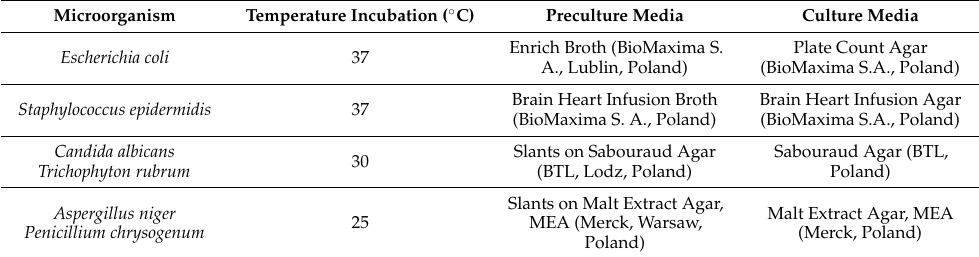
Table 1. Incubation conditions and preculture and culture media used in antimicrobial tests. Microorganism Temperature Incubation ( ◦ C) Preculture